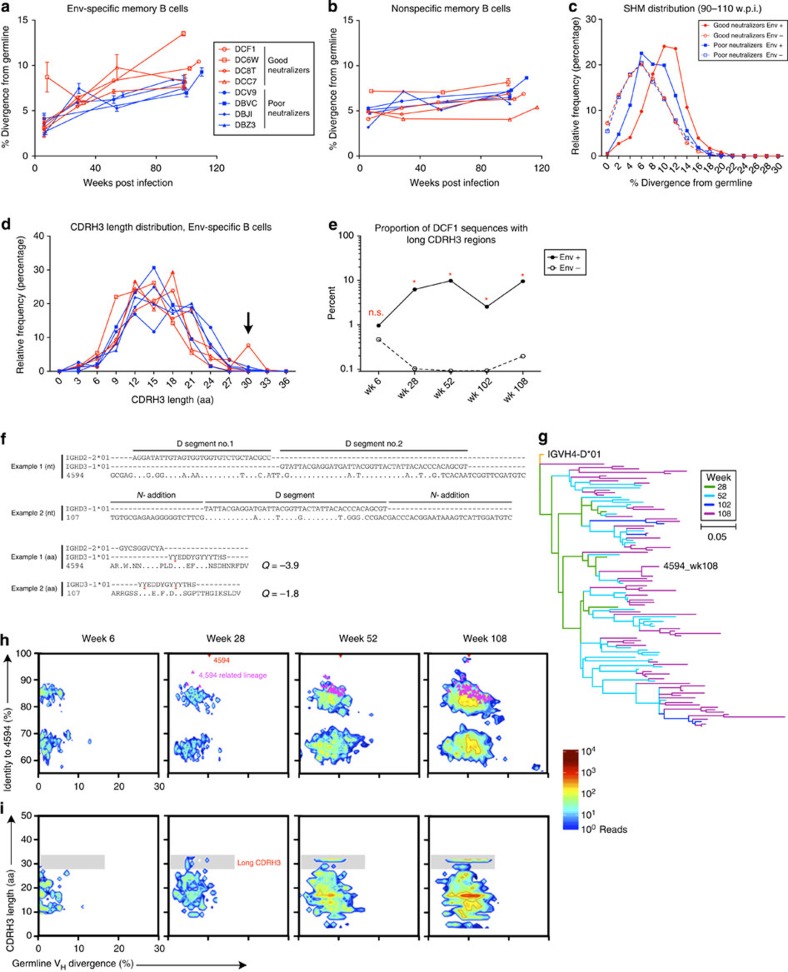
Next-generation sequencing of antigen-specific B cells after SHIVAD8 infection.Data are shown from four good neutralizers, red; and four poor neutralizers, blue. (a,b) SHM for each animal over time; each symbol represents the average percent divergence from germline for Env-specific (gp120+) (a) or nonspecific (gp120−) (b) sequences from a given animal; error bars indicate s.e.m. (c) Histogram representation of SHM distribution from all sequences from 90–110 weeks post infection; binning averaged in 2% increments. (d) CDR H3 length distribution of Env-specific sequences from individual animals for all time points combined. Colour/symbol scheme as in a; binning averaged in 3-aa increments; arrow indicates population of sequences with long CDR H3 regions. (e) Proportion of unique sequences with long CDR H3 regions from DCF1 at the indicated time points. χ2-test with Yates correction was used to calculate P values between proportions from Env+ or − samples at each time point; n.s., not significant; *P<0.0001. (f) Long CDR H3 regions from DCF1 may be derived in at least two unique ways. Example 1 depicts the CDR H3 region of sequence 4594, arising from V(DD)J recombination. Example 2 depicts the CDR H3 region of sequence 107, arising from N-addition. Bold text indicates mature antibody sequence; red stars indicate predicted tyrosine sulfation; CDR H3 charge is shown. (g) Divergence over time of long CDR H3 antibodies from the parent lineage that includes sequence 4594. A phylogenic tree was constructed by maximum likelihood and rooted to the IGHV4D*01 allele and is colour-coded by time point. (h,i) Two-dimensional plots depicting Env-specific sequences from animal DCF1 at the indicated time points. Sequences are plotted by their VH divergence from germline and their identity to the 4594 HC (h); or by their CDR H3 length (i). Red triangle indicates sequence 4594; magenta triangles indicate sequences related to 4594; shaded boxes indicate reads with long CDR H3 regions.